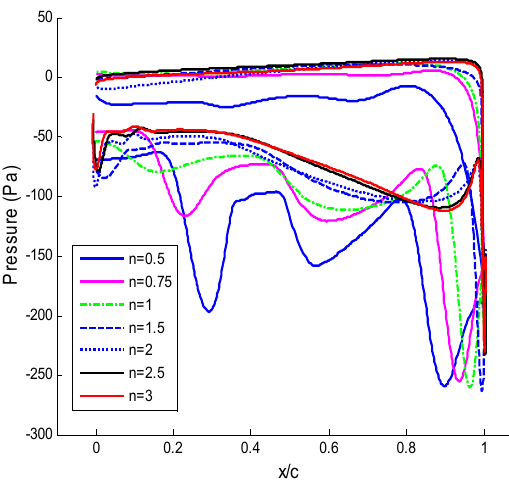
Figure 11. Pressure distributions on the blades for λ = 0.8 and θ =